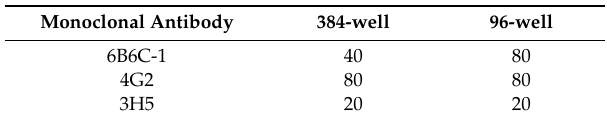
Table 4. Neutralizing Titers of Anti-E Monoclonal Antibodies (EMNT 50 ) to DENV-2 Using BHK-21 Cells on Both 96-Well and 384-Well Plates.